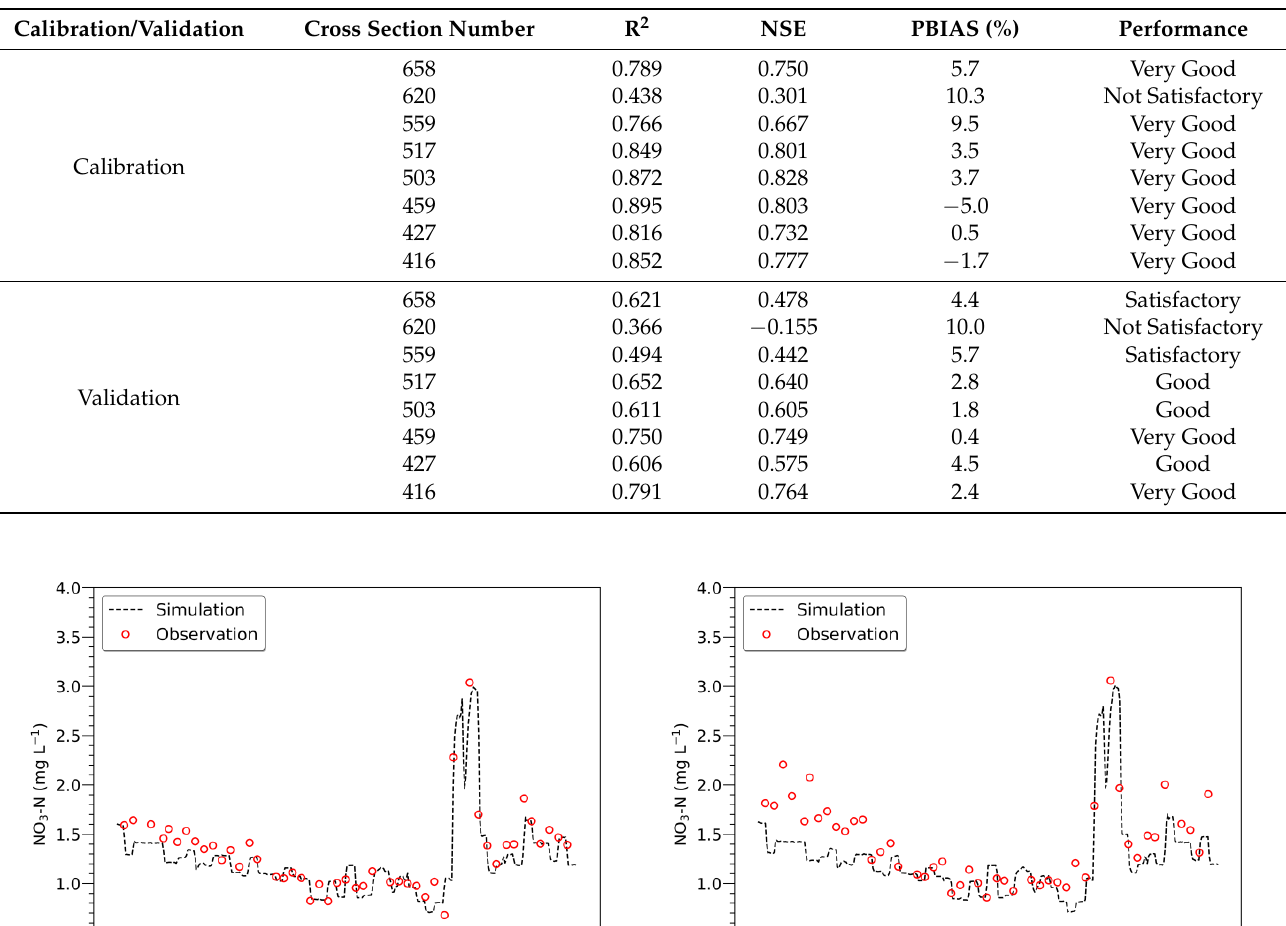
Table 9. Model performance for NO 3 -N.